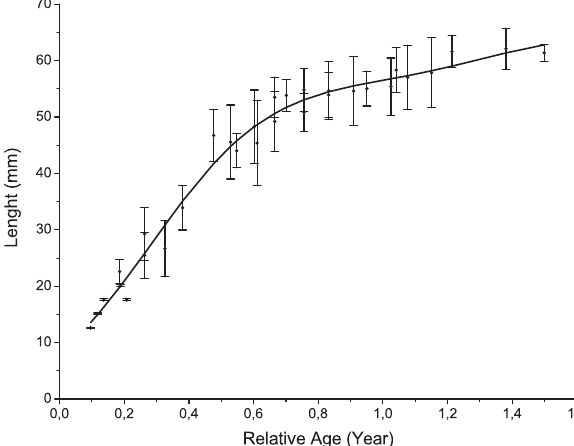
) theoretical age Figure 4. Tagelus plebeius . VBG growth curve with seasonal oscilla- o tion. The bars represent the standard error of the